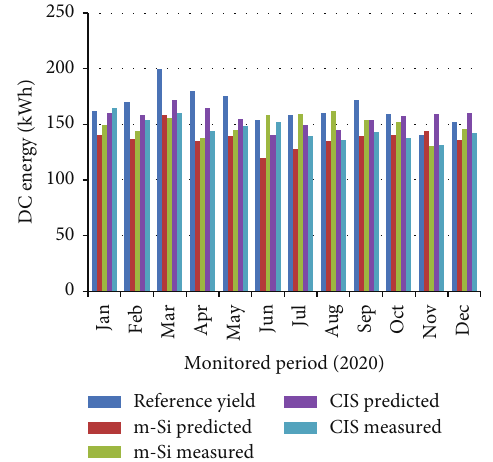
Figure 4: CIS and m-Si PV array ’ s predicted and measured array yield